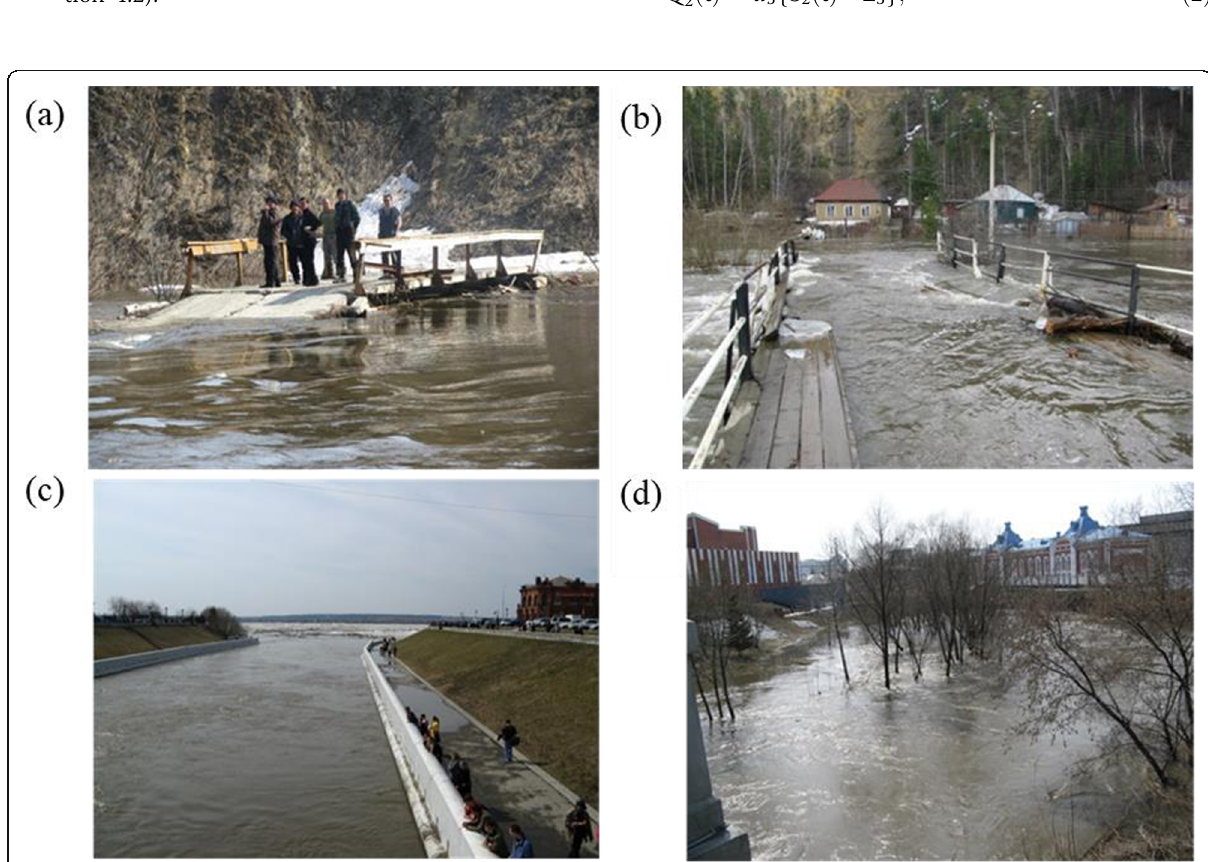
Fig. 3 Snowmelt-driven flood disasters in Tomsk neighborhoods at the end of April 2010. a , b April 28, 2010; c , d April 30, 2010 (Territorial Center “ Tomskgeomonitoring ”